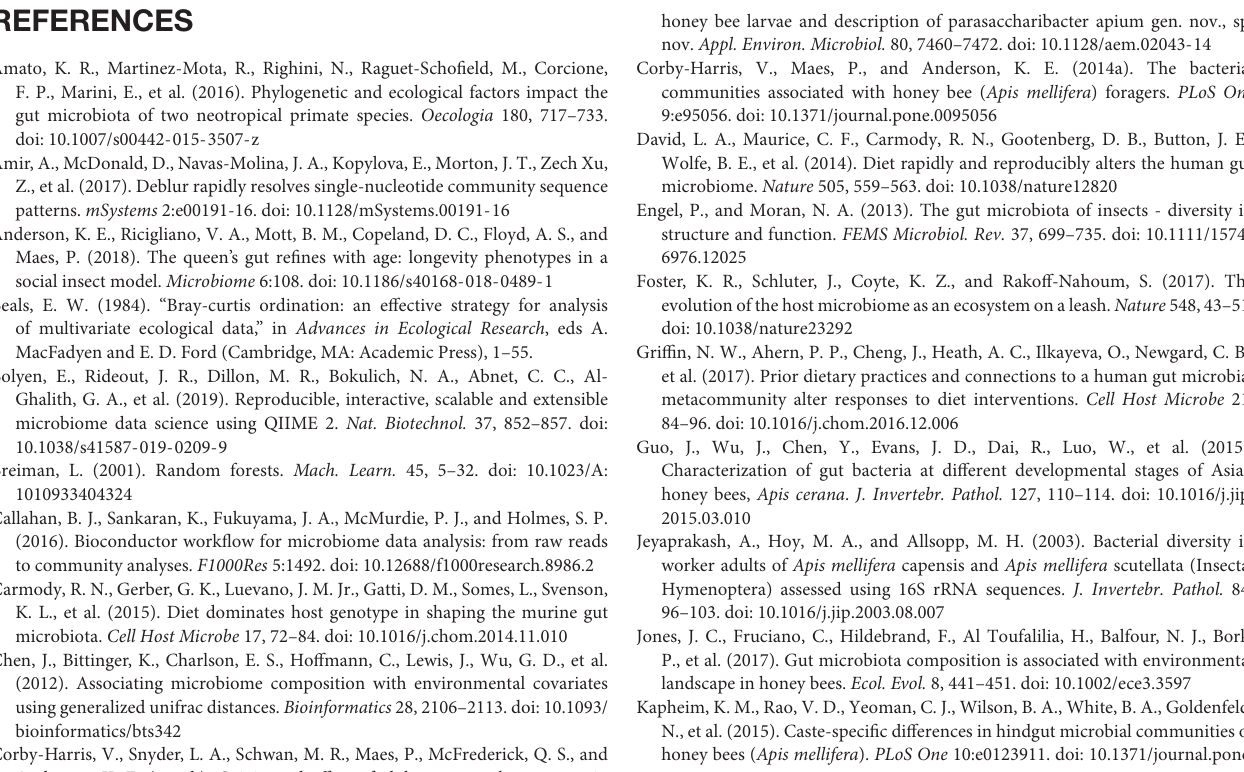
Supplementary Figure 1 | The barplot of the composition of queens’ gut microbial community in phylum level. Supplementary Figure 2 | (A) The principal co-ordinates analysis (PCoA) plot based on the unweighted UniFrac matrix of queens’ midgut microbiota. (B) The principal co-ordinates analysis (PCoA) plot based on the unweighted UniFrac matrix of queens’ rectum microbiota. Supplementary Figure 3 | The dendrograms rebuilt using UPGMA method based on unweighted UniFrac distance. Supplementary Figure 4 | The top 45 diverse taxa detected by RFC